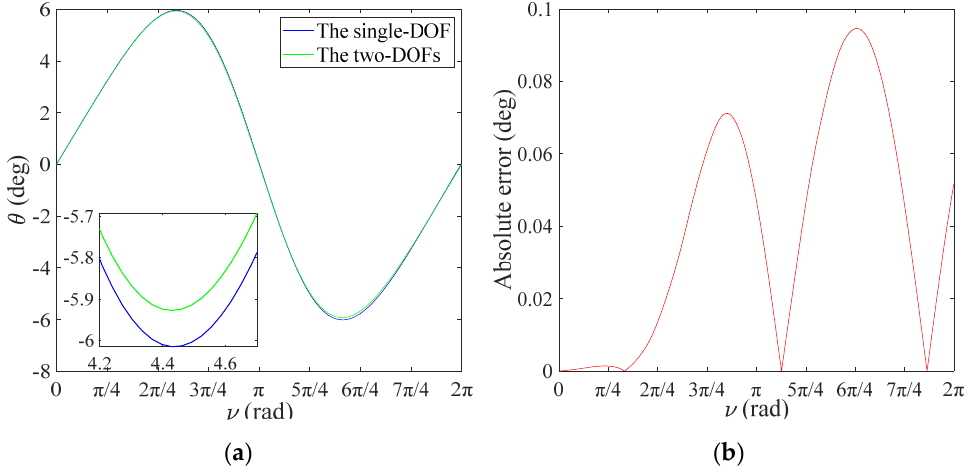
Figure 4. Coupling effects of φ , e = 0.1: ( a ) numerical comparison for θ ; ( b ) absolute error for θ .